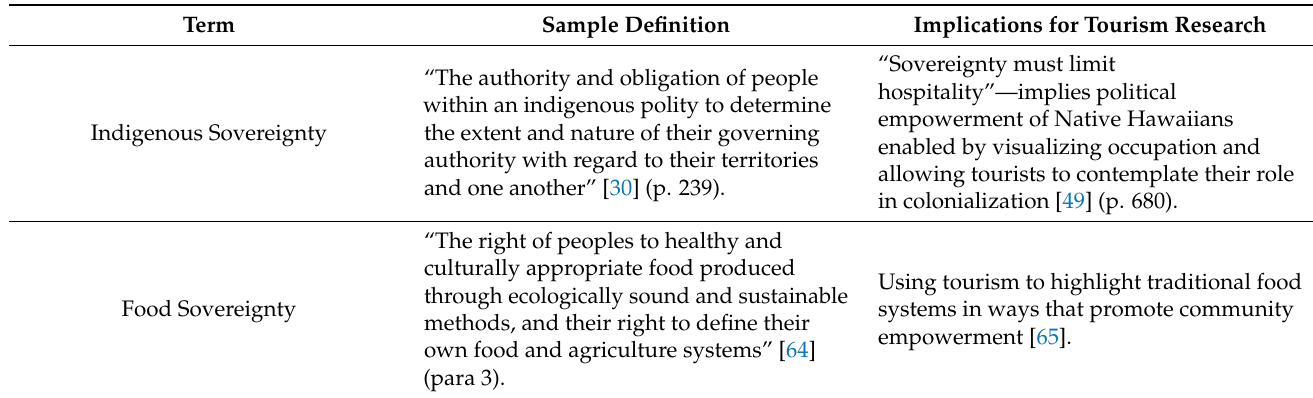
Table 1. Definitions of key forms of sovereignty and examples of their relation to tourism development.